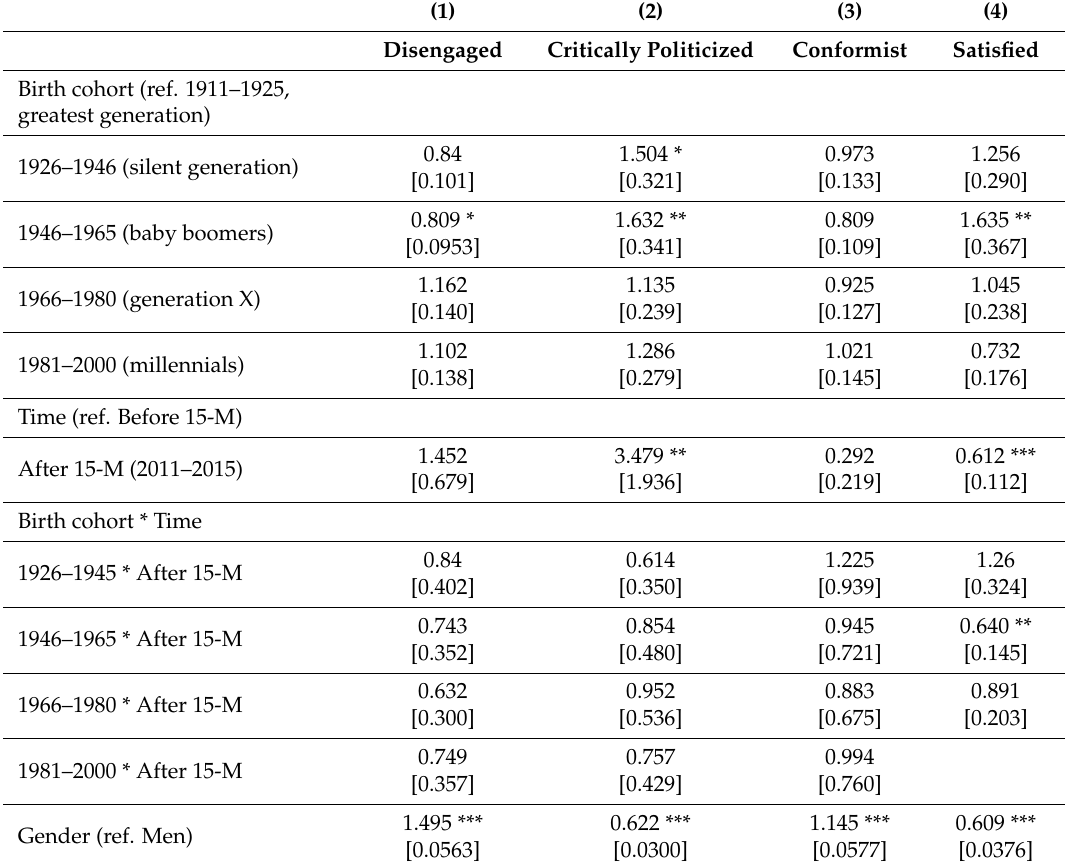
Table A4. Logistic regression estimates for the determinants of attitudes towards politics. Odds